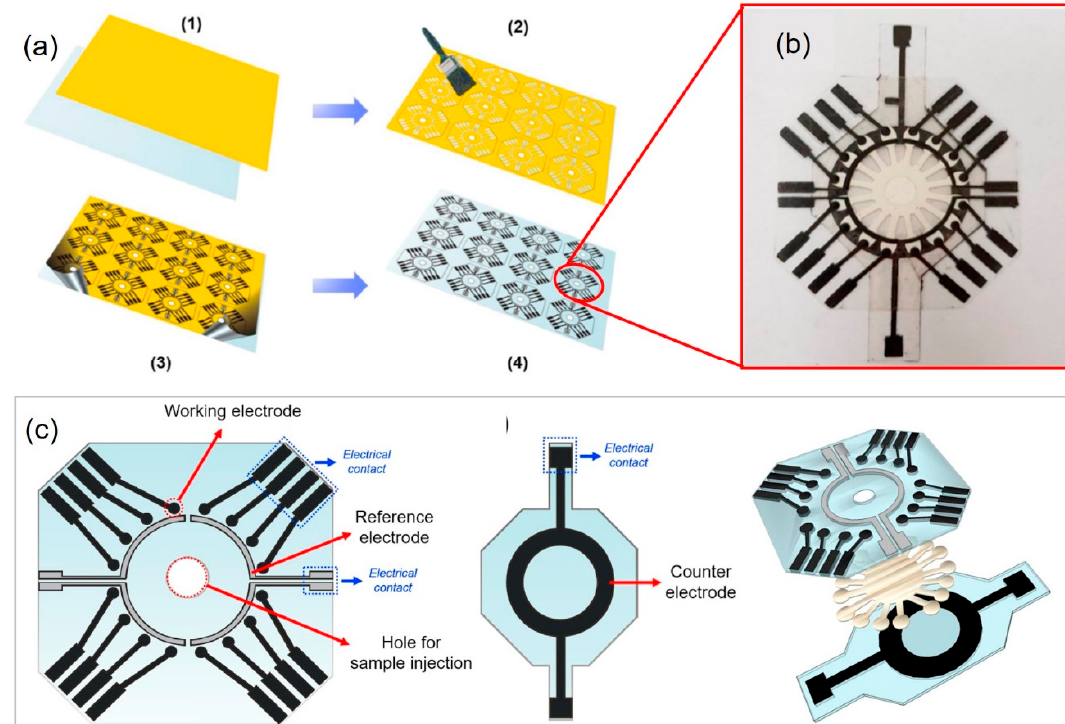
Figure 7. ( a ) Schematic representation of electrode construction, consisting of the following steps: (1) a vinyl adhesive is fixed onto a polyester sheet; (2) the adhesive is cut in the desired design, followed by the deposition of carbon conductive ink; (3) removal of the adhesive after the inks have dried; (4) a batch of electrodes ready to be assembled with the microfluidic device. ( b ) Photograph of an assembled 16-microfluidic channel platform. ( c ) Steps for device layer assembly consisting of the WEs / REs and CE layers’ design. Reproduced with permission from the authors of [137]. Copyright 2019, Elsevier B.V.